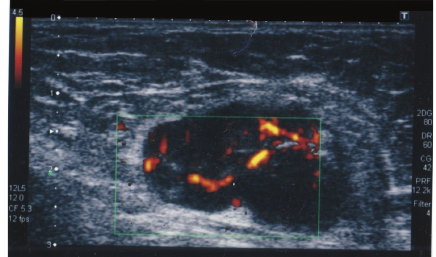
Figure 2: Ultrasonography of the left axillary shows an enlarged lymph node of about 35 mm with vascular poles at